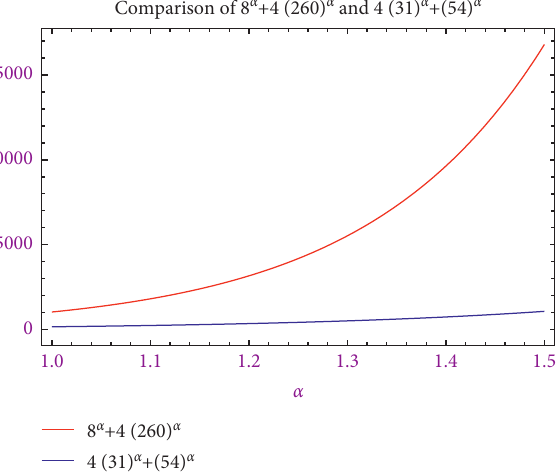
8 α +4 (260) α 4 (31) α +(54) α Figure 12: Plot for C − A , and it shows that C > A